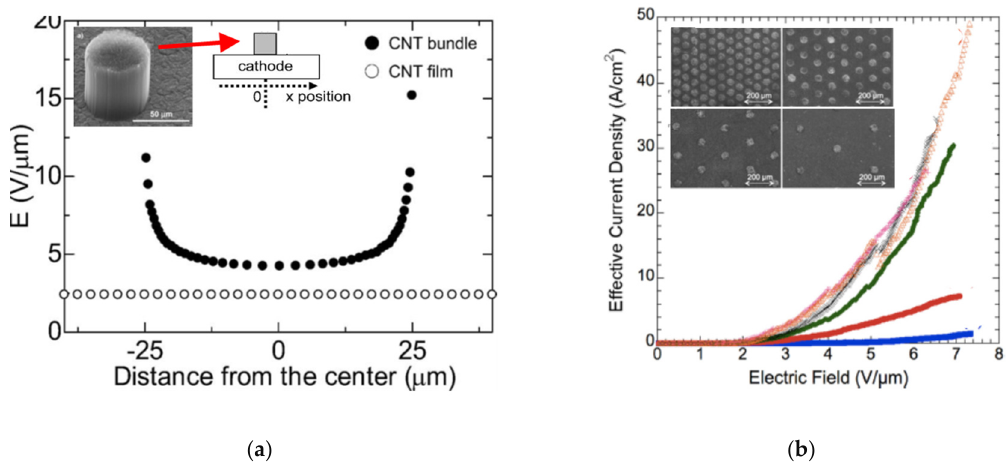
Figure 9. Influence of a design of a cathode on its emission: ( a ) the graph presenting simulation results for the FE cathode being a flat film and a bundle—the trend in electric field enhancement upon the distance from the center of the cathode, and the inset shows the bundle SEM image (left) and a schematic image (right); ( b ) the FE characteristic of the cathodes arrays with various distances between them, and the inset shows SEM images of these FE cathodes. Figure 9a,b reprinted with permission from [118,119],